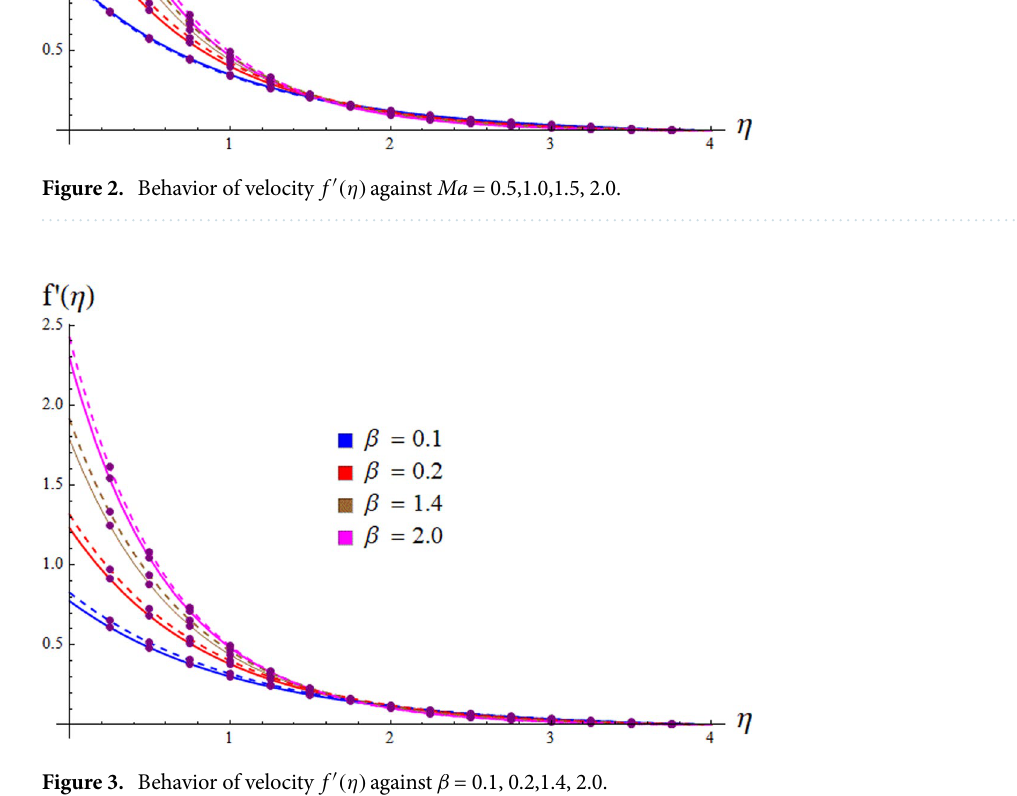
Figure 3. Behavior of velocity f ′ (η) against β = 0.1, 0.2,1.4,